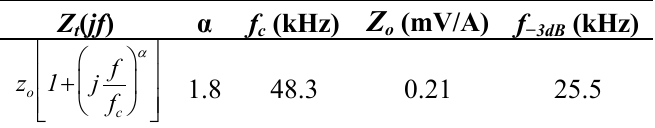
Table 2. GMR-SV sensor ac large-signal fractional modeling